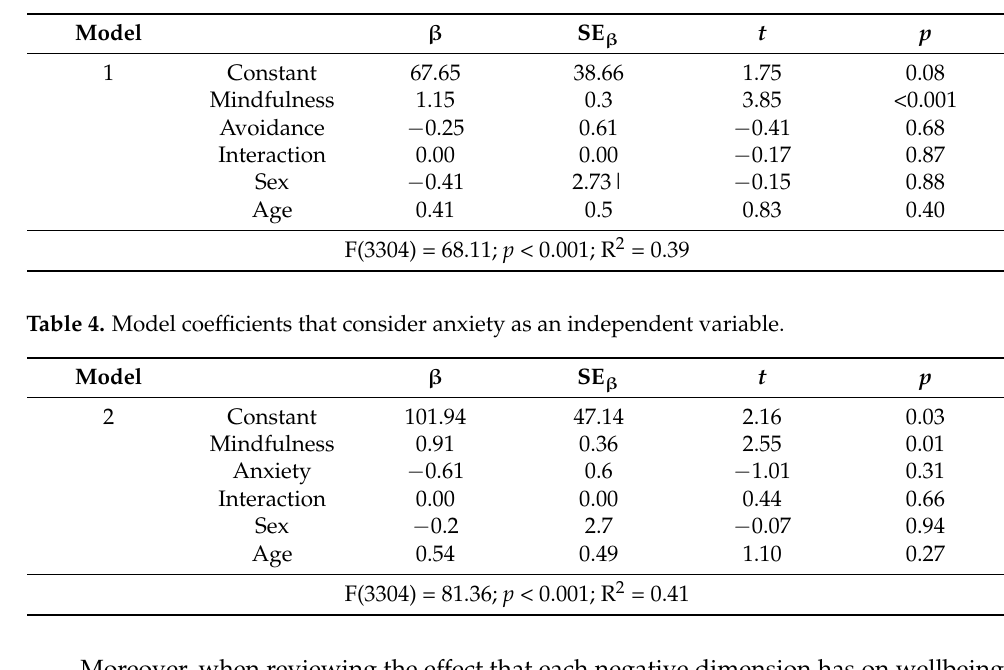
Table 3. Model coefficients that consider avoidance as an independent variable.